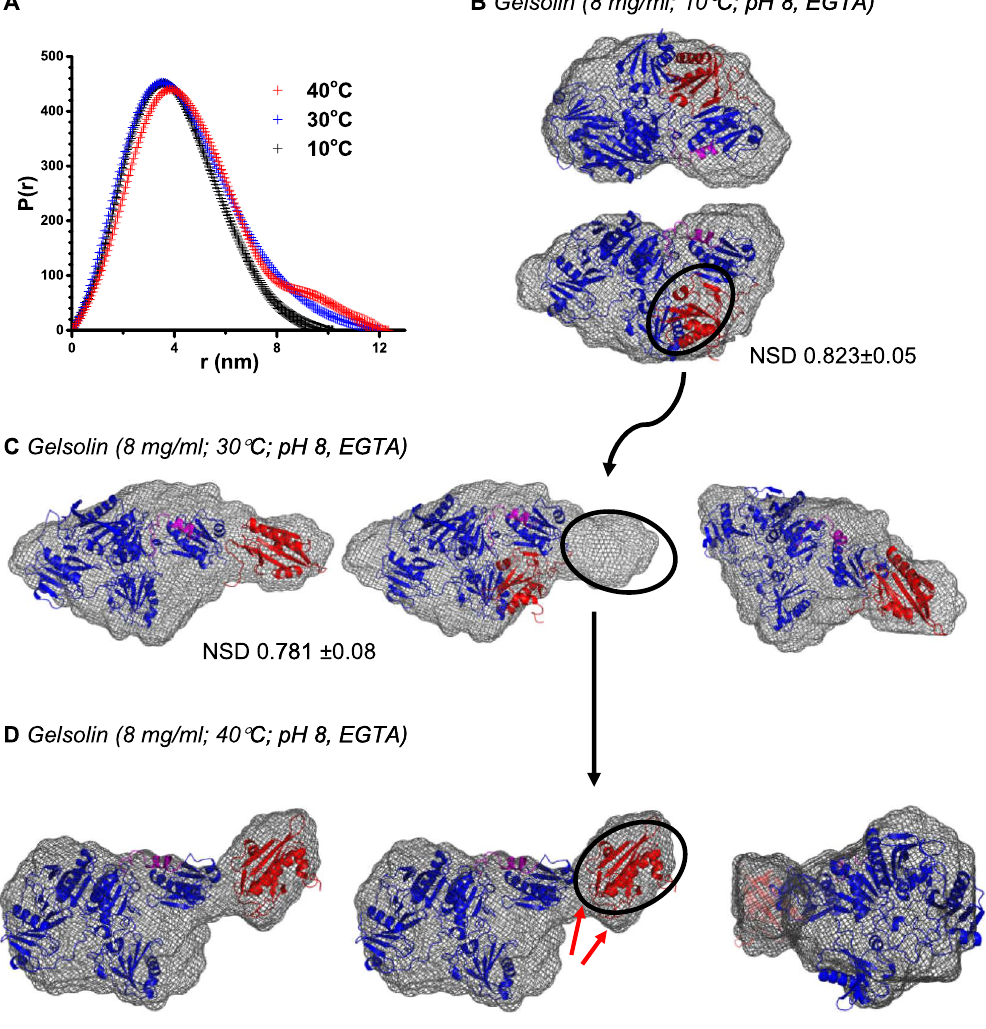
Figure 4. ( A ) The P(r) profiles computed using SAXS data profiles collected for 8 mg/ml gelsolin shown in Fig. 2A are plotted here for temperatures 10, 30 and 40 °C. ( B – D ) The SAXS data based dummy residue model solved for gelsolin protein at temperatures 10, 30 and 40 °C are presented. The dummy residues are shown as grey mesh. As discussed in main text, for each SAXS data based model, either crystal structure of Ca 2 + -free gelsolin or its simplistic reoriented model was used to assess the shape rearrangements seen in the SAXS data based dummy atom models. In all structural models used with SAXS data based models, the G1 domain and g1–g2 linker, and the C-tail latch are depicted in red and magenta coloured ribbons, respectively. Additionally, the black circle drawn highlights the location of G1 domain and the arrows between different panels track its repositioning as a function of